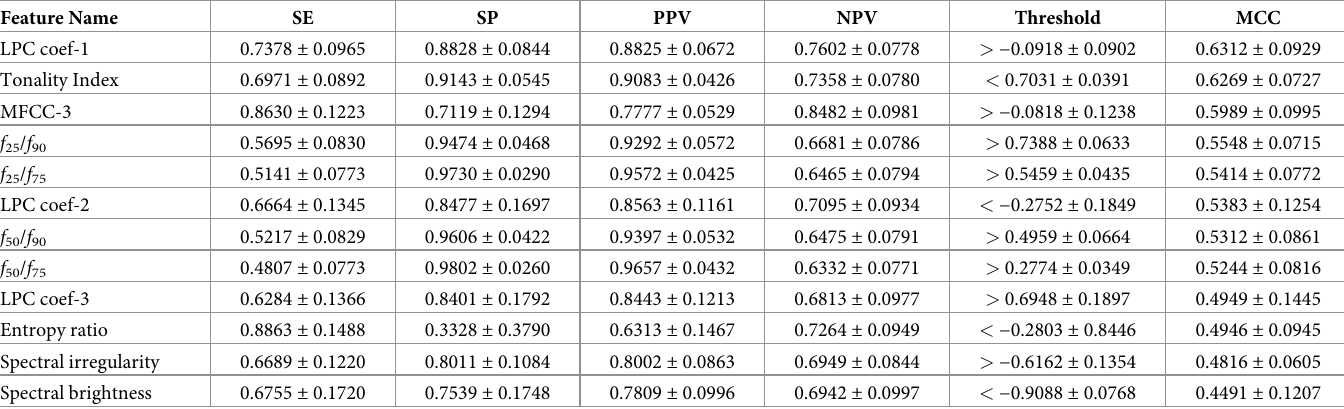
Table 5. Classification result using optimum MCC threshold on the